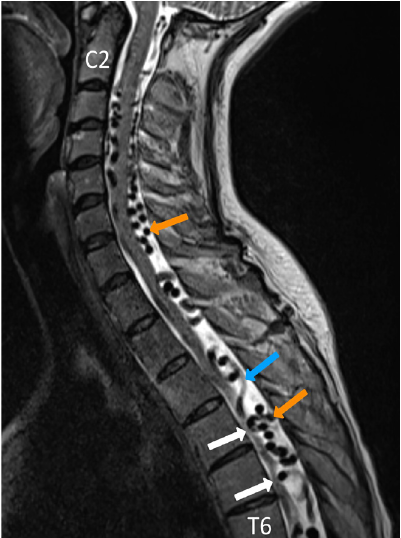
Image 1. Sagittal magnetic resonance imaging T2-weighted image of the cervical and thoracic spine. Flow voids appear black against white cerebrospinal fluid, and indicate extensive dilated vessels suggestive of dural arteriovenous fistulas. Orange arrows identify vessels perpendicular to the plane of the image, blue arrow identifies vessel at an angle to the plane with relatively increased signal. The white arrows highlight areas of spinal cord being compressed or deformed out of plane by dilated